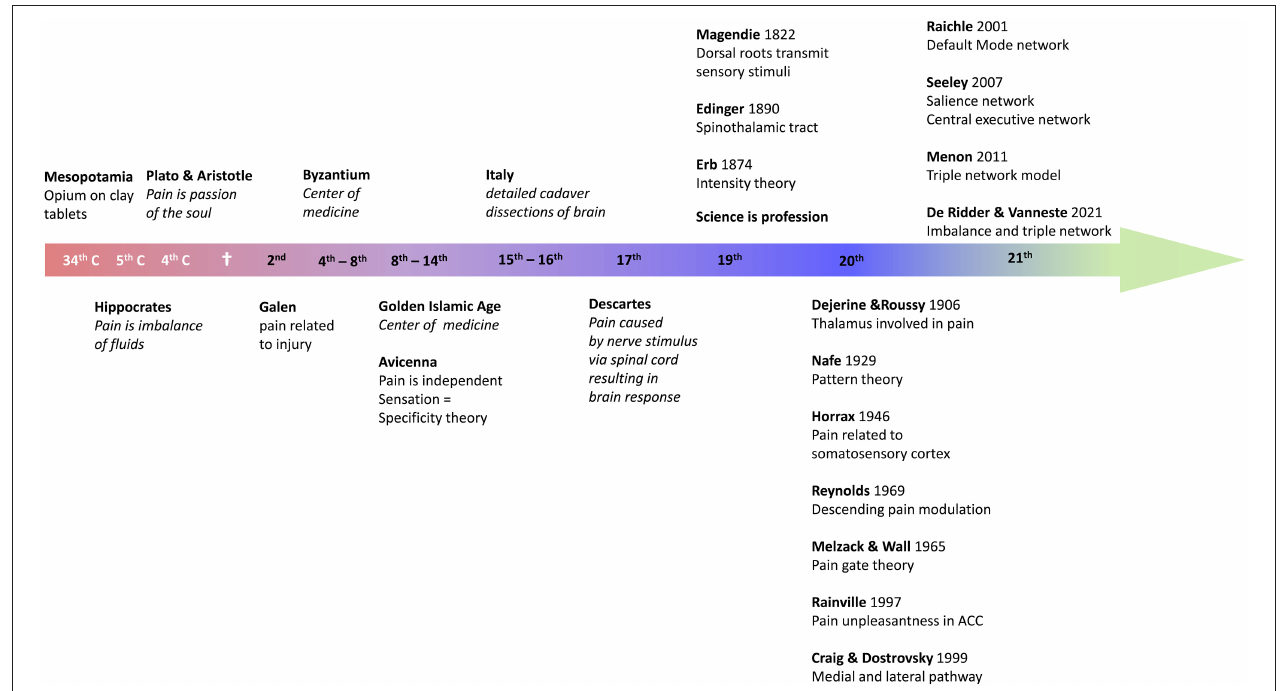
FIGURE 1 | Overview of the history of pain